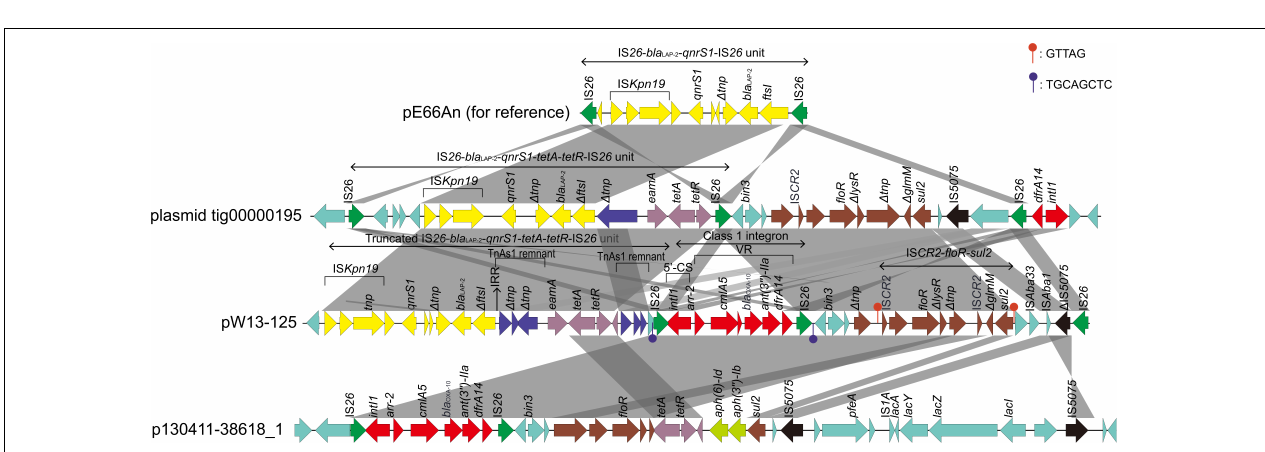
FIGURE 3 | Comparison of the genetic environment of the bla YOC - 1 gene with those carrying its homologous genes. Genes are shown as arrows and colored based on gene function classification. Genes without functional annotation are colored in gray. Shading denotes homologous regions between them. MFS represents the genes encoding major facilitator superfamily (MFS) transport proteins.